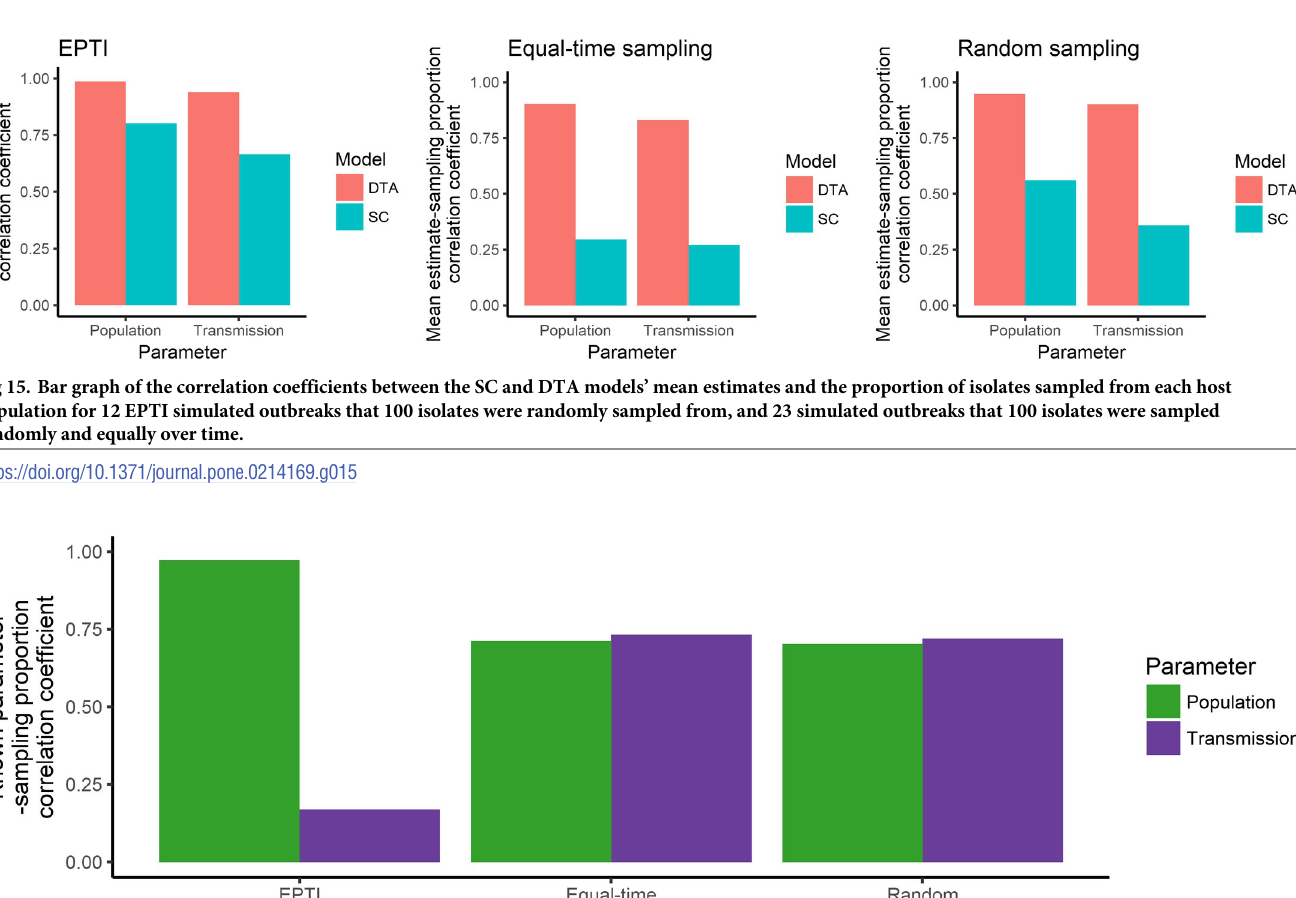
Fig 14. Sampled transmission tree (A), maximum clade credibility tree produced by the DTA model (B) and maximum a posteriori tree produced by the SC model (C), for a representative EPTI simulated outbreak that 100 isolates were randomly sampled from. The blue areas represent time spent in the human population and the red areas represent time spent in the animal population.